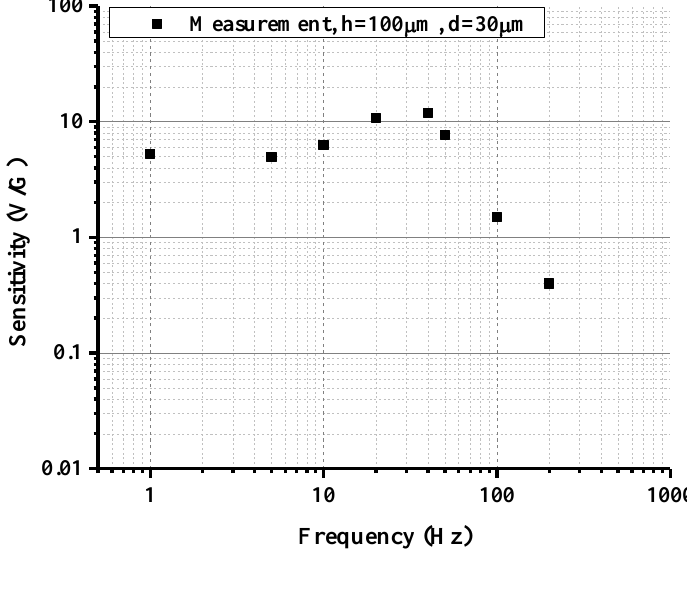
Figure 10. Measured sensitivity frequency response of the droplet-based micro MET